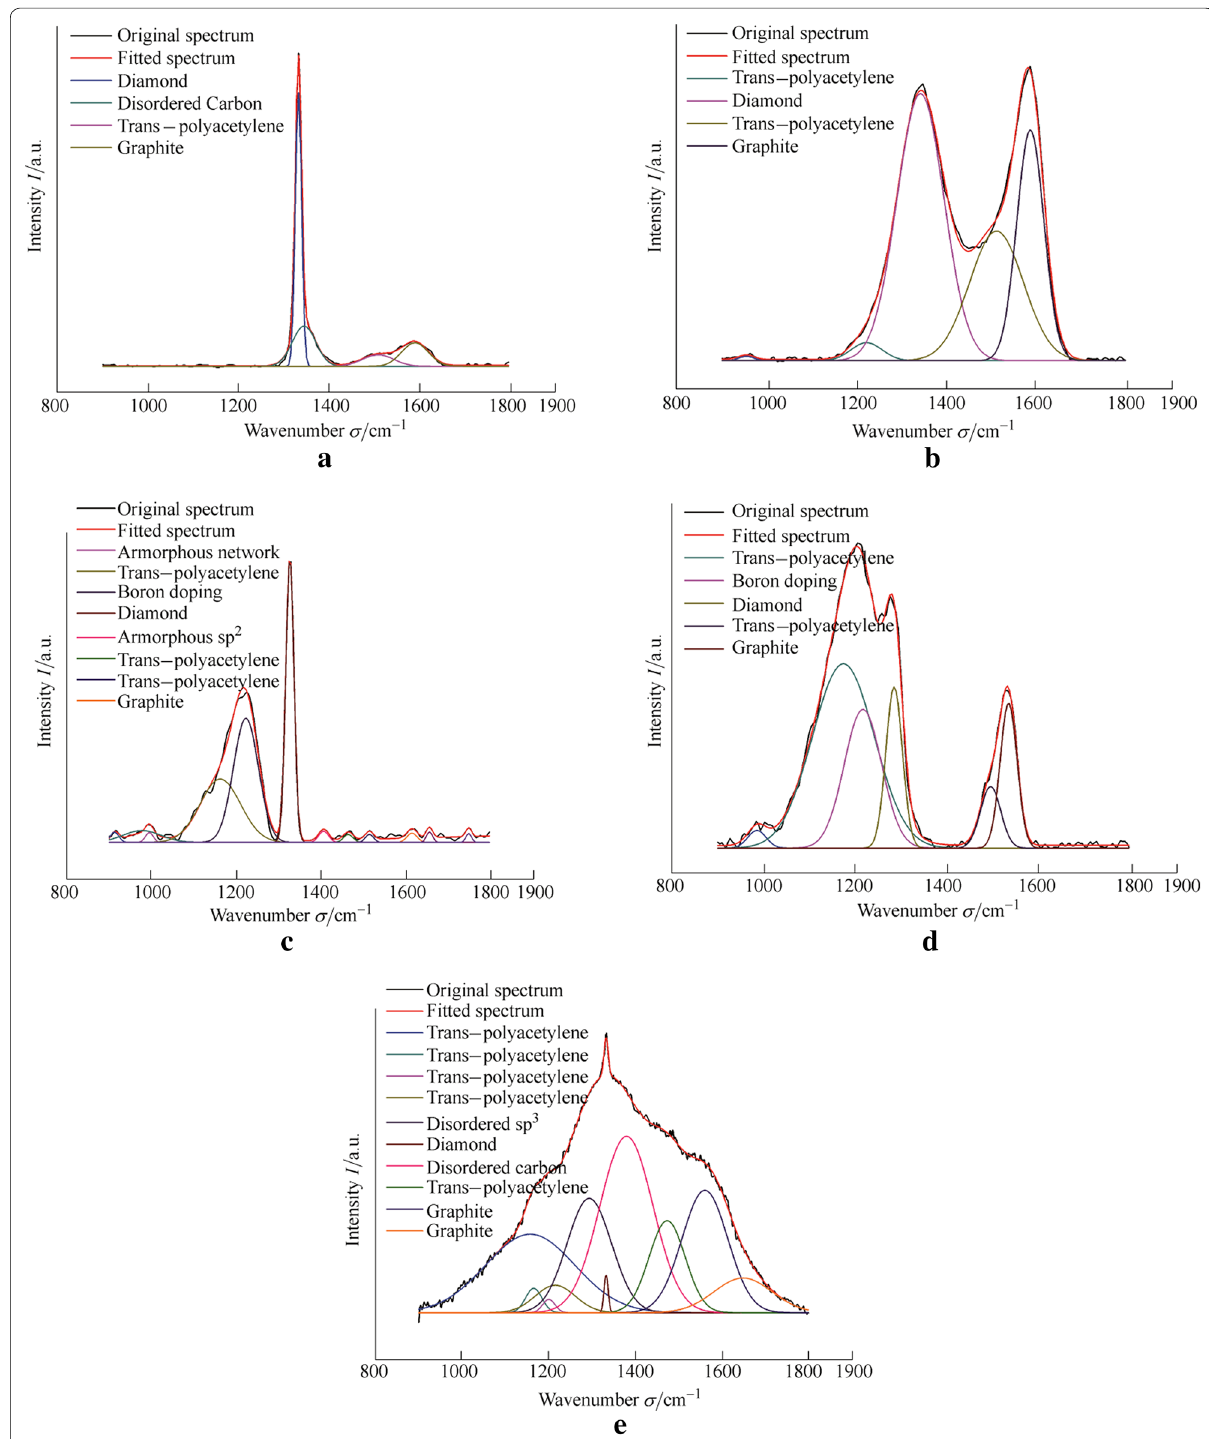
Figure 4 Raman spectra of a UMCD, b UFGD, c BDMCD, d BDFGD and e BDM‑UFGCD coated milling cutters before AFM